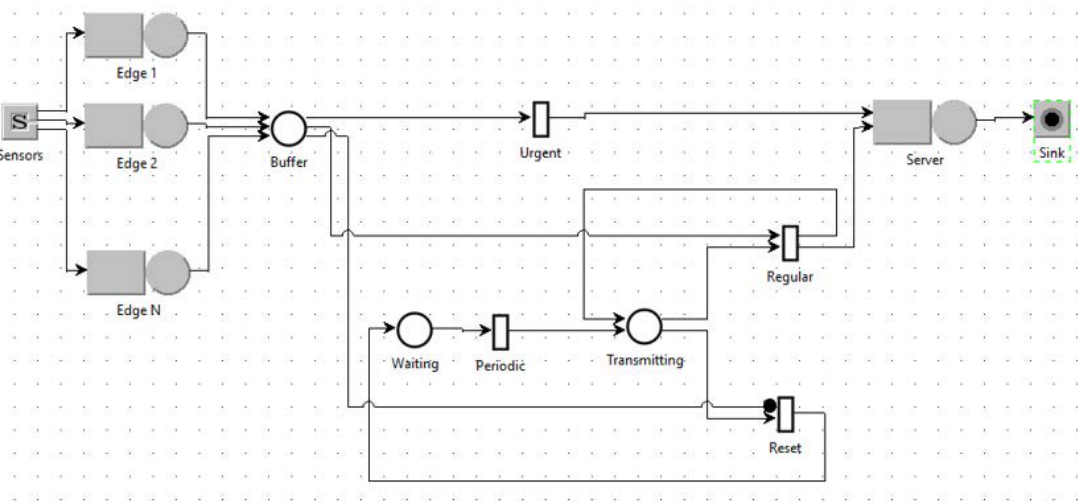
Figure 20. Layout of the model for the smart batching of signals in the e-Health scenario